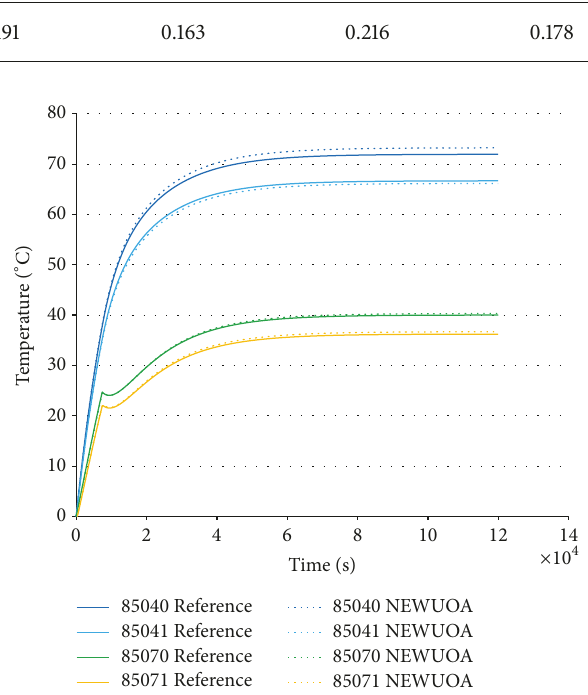
Figure 7: Transient hot case. Temperatures obtained from correla- tions with